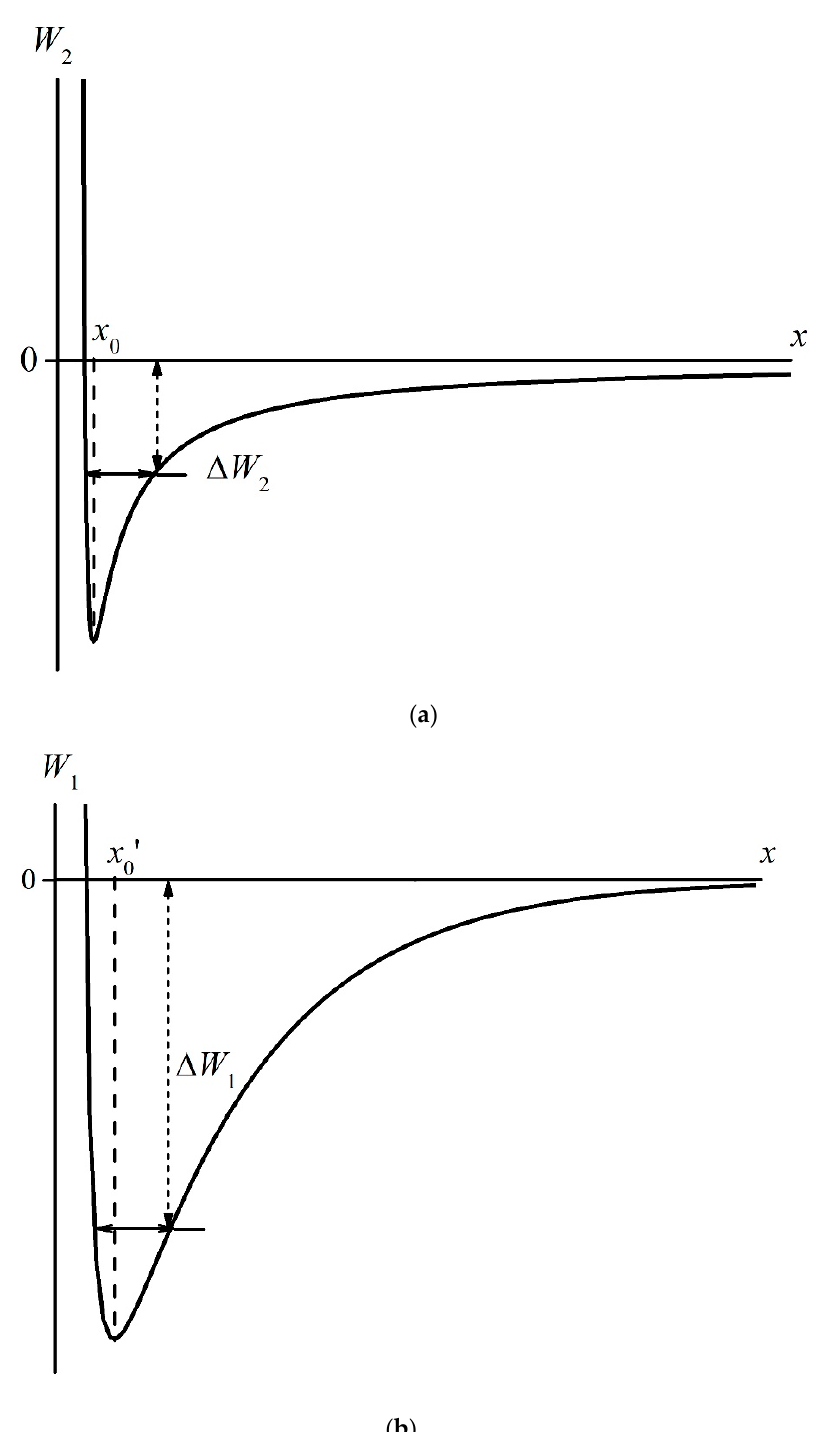
Figure 10. Potential energy of “MB + water + Nafion” complexes near the surface of Nafion. Panel ( a ) is related to the case C ( t ) = 0 (Equation (7), W 2 ( x )). Panel ( b ) is related to the case t = 0 (Equation (8), W 1 ( x, 0)).